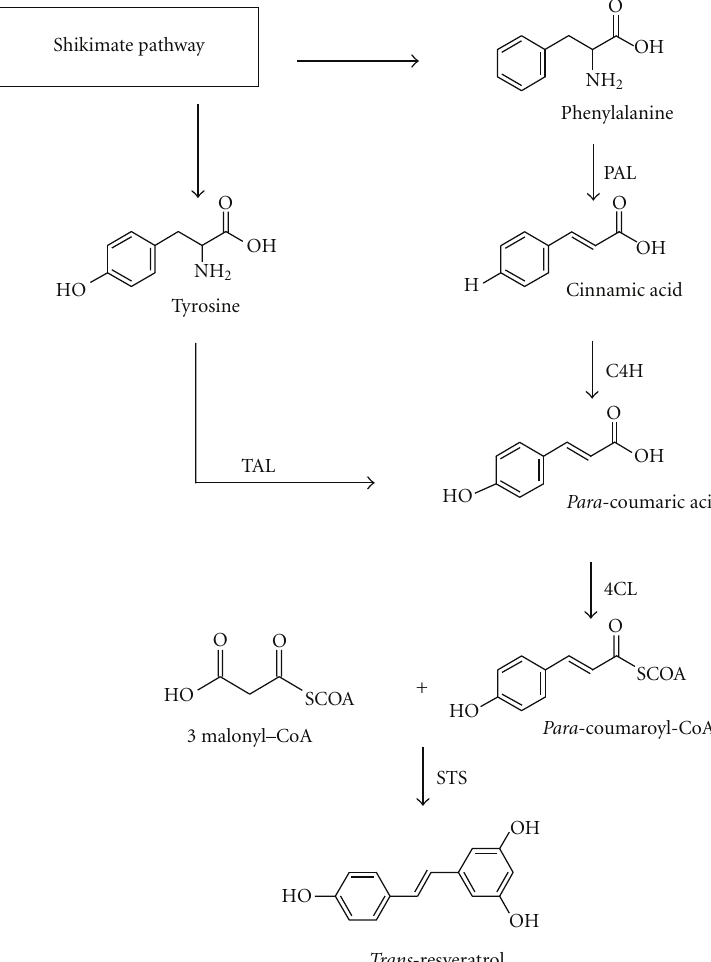
Figure 2: Biosynthesis of resveratrol via the phenylalanine/polymalonate pathway. PAL, phenylalanine ammonia lyase; TAL, tyrosine ammonia lyase; C4H, cinnamate-4-hydroxylase; 4CL, para -coumaric acid: coenzyme A ligase; STS, stilbene